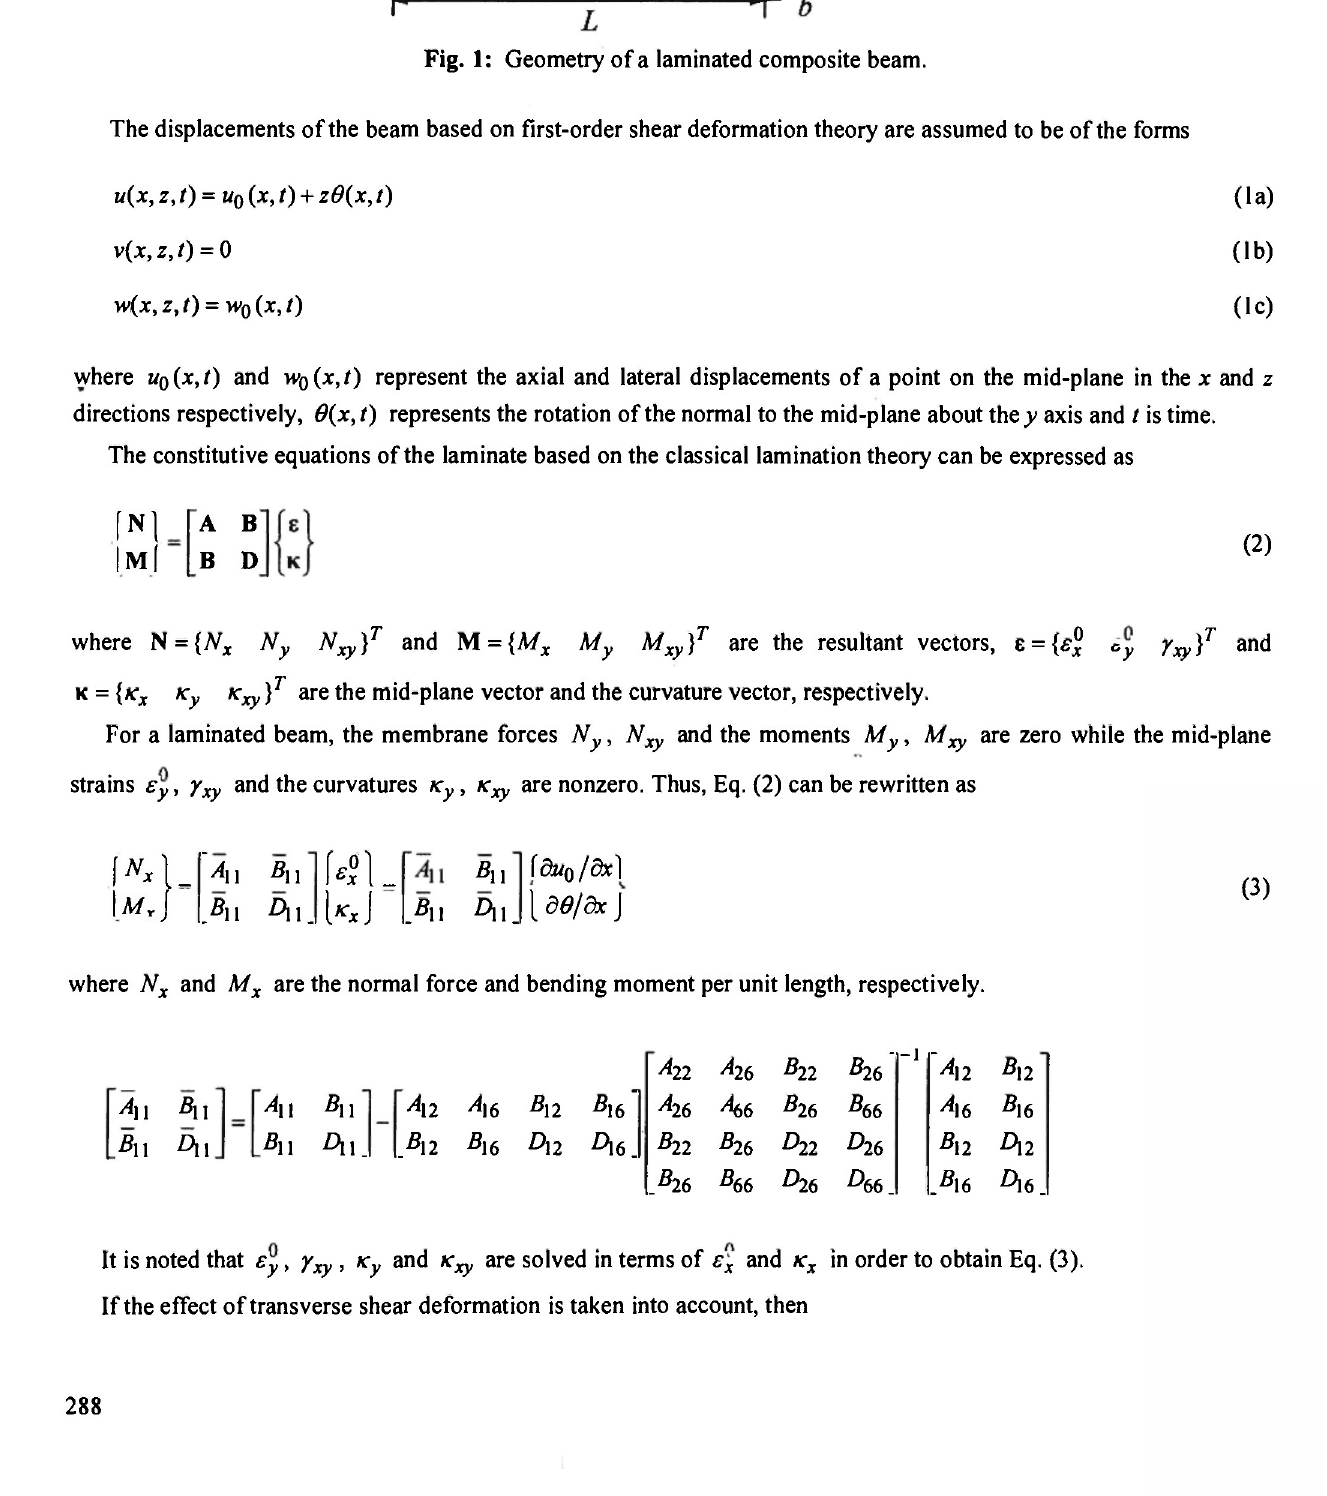
Fig. 1: Geometry of a laminated composite